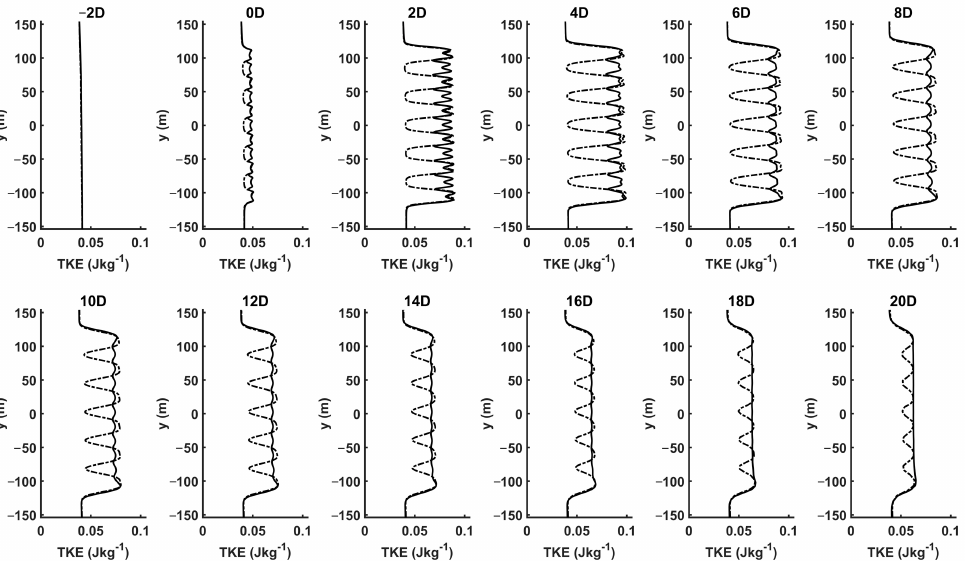
Figure 7 . Horizontal distribution of the turbulent kinetic energy (TKE) at the hub height (15 m above the flat seabed) at different streamwise positions from the fence of devices. Continuous and dashed lines correspond to a lateral spacing of 1.5 D and 3 D , respectively. The values have been extracted, at peak flood tide, from the simulation with AD with 𝐾 = 3 ( 𝑎 = 0.33 and 0.34 for Δ = 1.5 D and Δ = 3 D , respectively). The orientation of the axis 𝑦 differs from that retained in Figure 1.